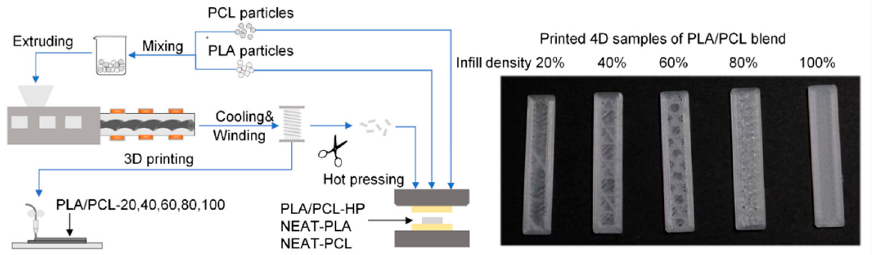
Figure 1. The fabrication process of PLA/PCL filaments and 4D samples by ME printing and hot pressing.